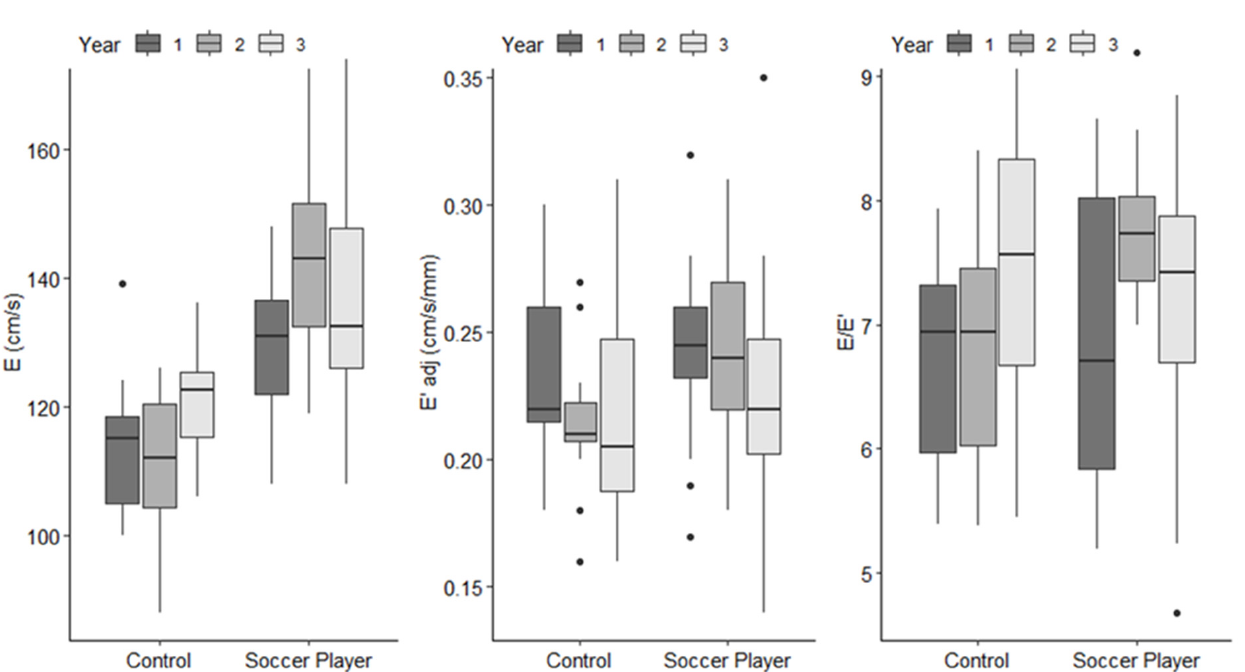
Figure 5. Changes in TDI derived markers of systolic (peak aortic velocity and S’adj) and diastolic function (E, E’adj and E/E ′ ) during submaximal exercise at approximately 45% 𝑉(cid:4662) 𝑂 (cid:2870)(cid:3043)(cid:3032)(cid:3028)(cid:3038) in the control participants and soccer players over the course of the three-year observational study. All values are median and inter-quartile range. Unnithan et al. 2022 [1]. Reprinted with permission from Unnithan et al., [1], 2022, John Wiley and Sons.